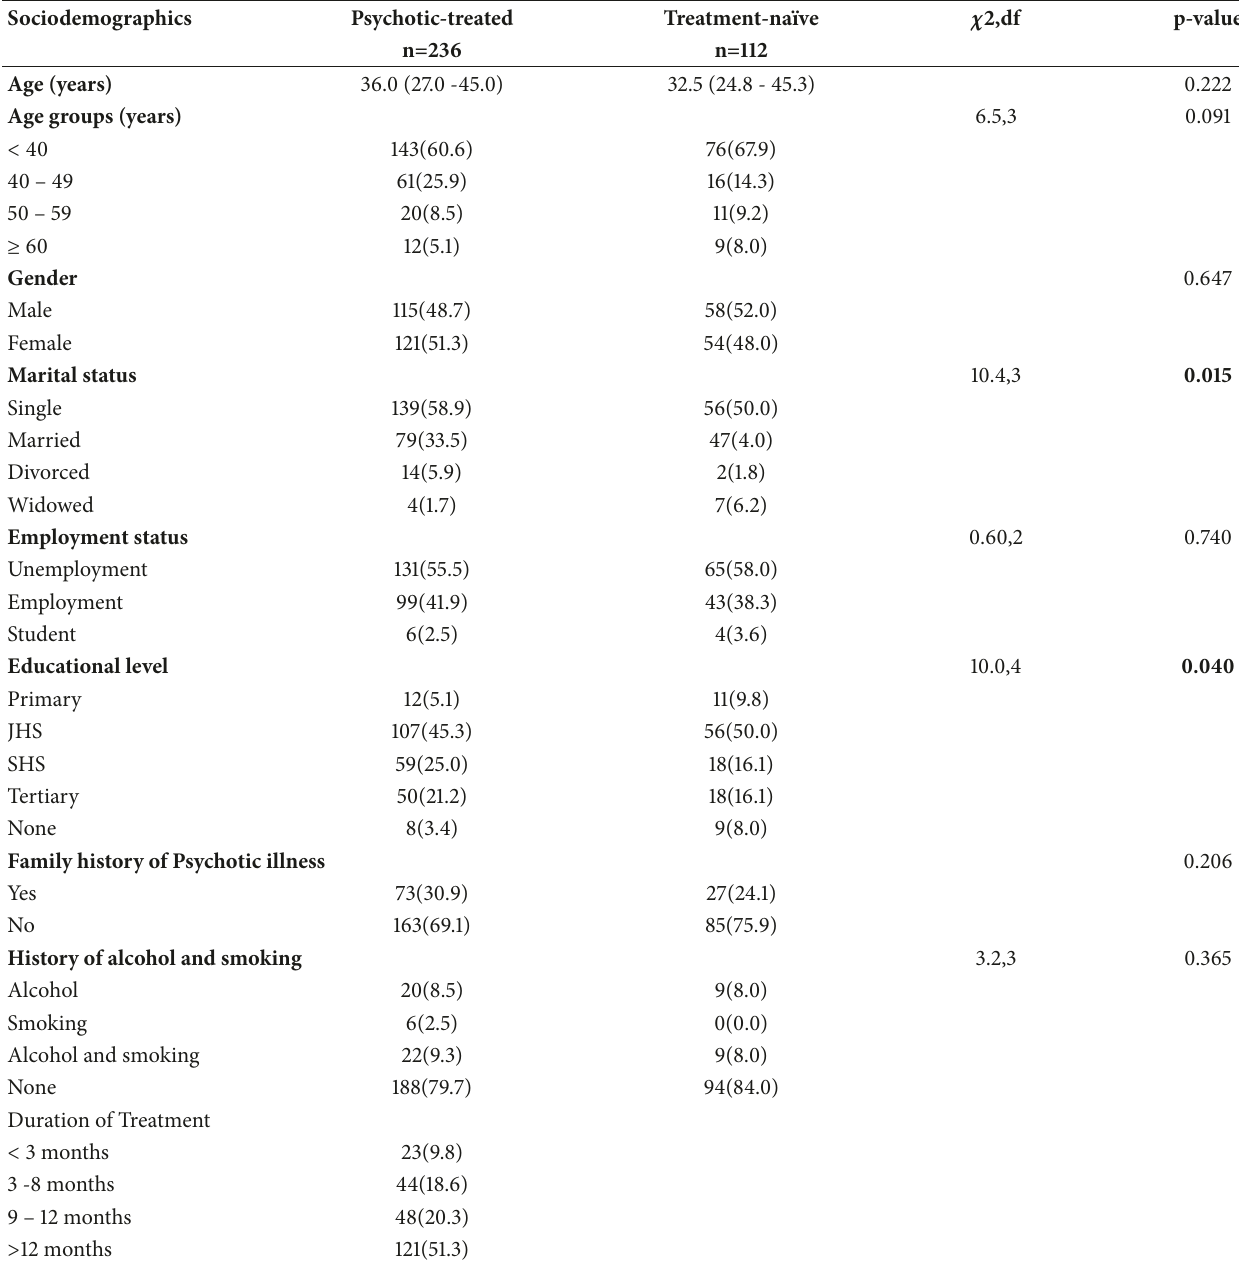
Table 1: Sociodemographic characteristics of study